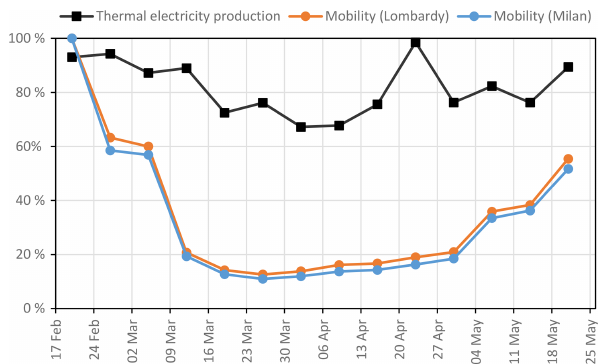
Figure 2. Variations in activities resulting from lockdown measures (2020). Percentages are calculated in comparison with 2019 data for thermal energy production (source: https://www.terna.it, last